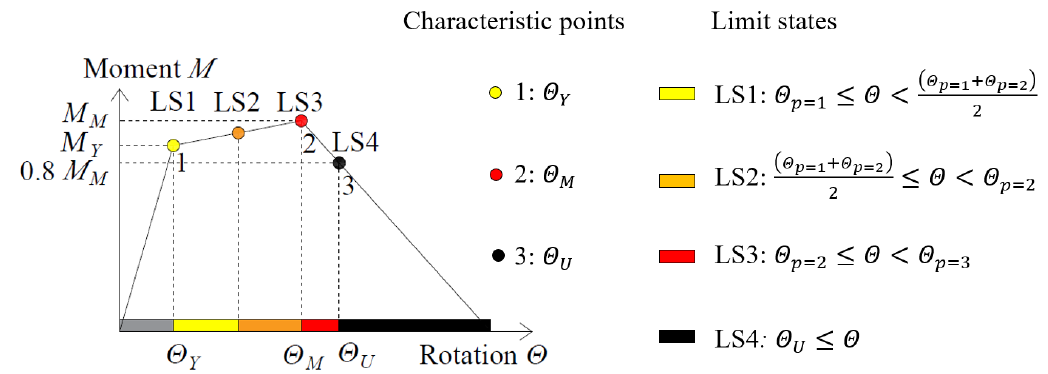
Figure 2. Tri-linear moment-rotation relationship accounting for linear softening branch, characteristic points (p = 1, 2, 3) needed for the definition of moment-rotation relationship, and four limit states (LS1-LS4) for vertical structural elements (e.g., columns and walls).